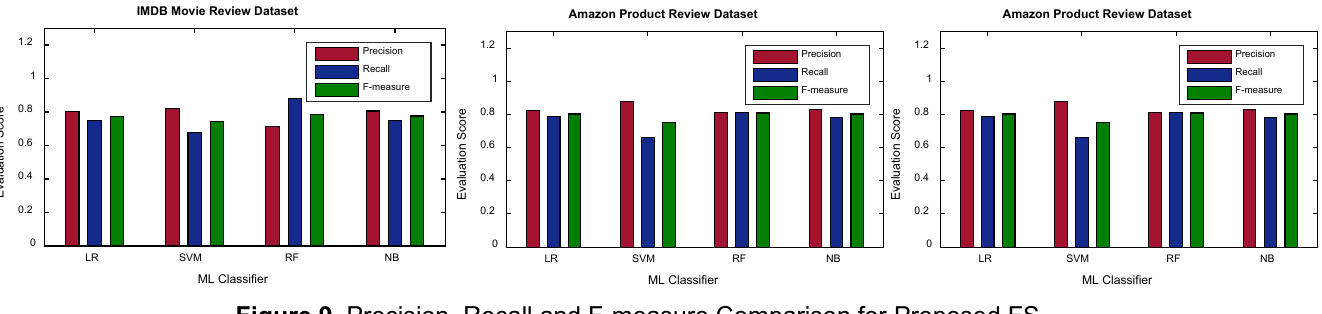
Figure 9. Precision, Recall and F-measure Comparison for Proposed FS Table 9. Confusion Matrix of IMDB Movie Review